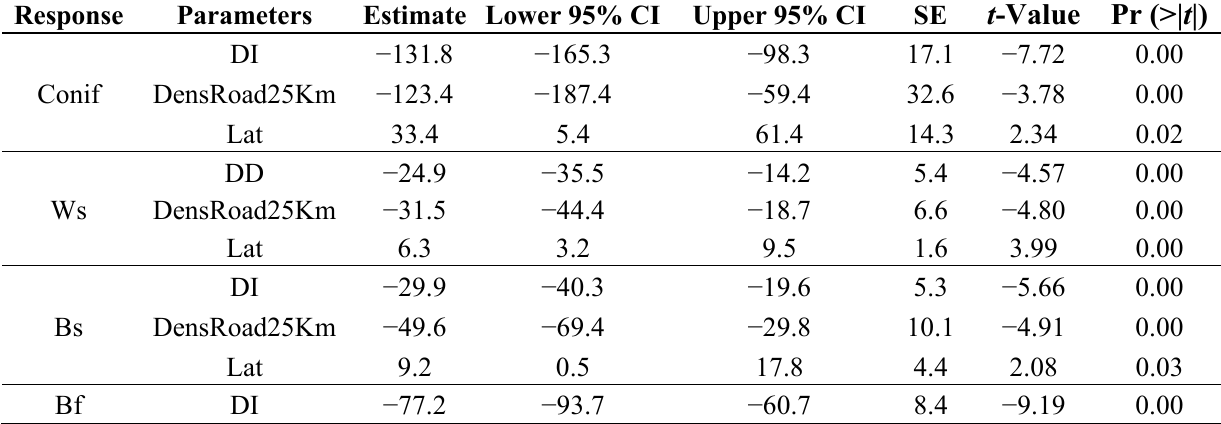
Table 4. Summary of the multiple regression (variables significant at p <